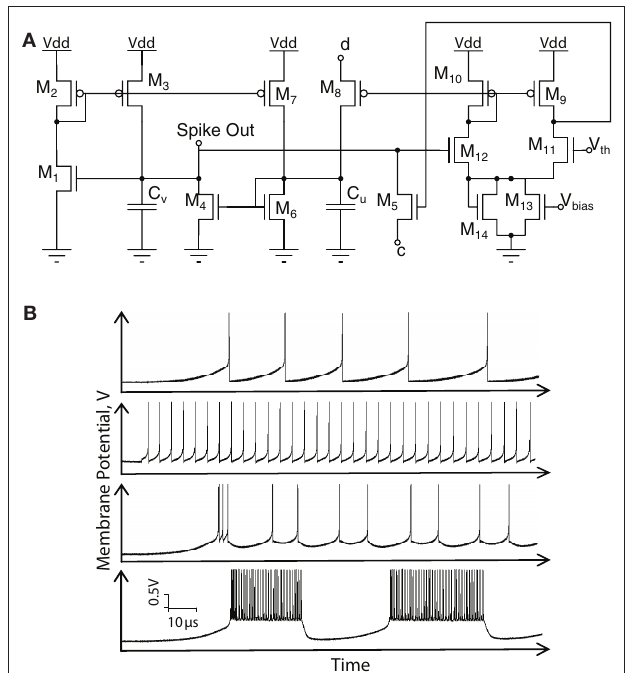
FIgure 16 | The Izhikevich neuron circuit (a) schematic diagram, (b) data recorded from the 0.35 μm CMoS VLSI implementation: spiking patterns in response to input current step for various parameters of bias voltages at node c and node d: regular spiking with adaptation, fast spiking, intrinsically bursting, chattering (top to